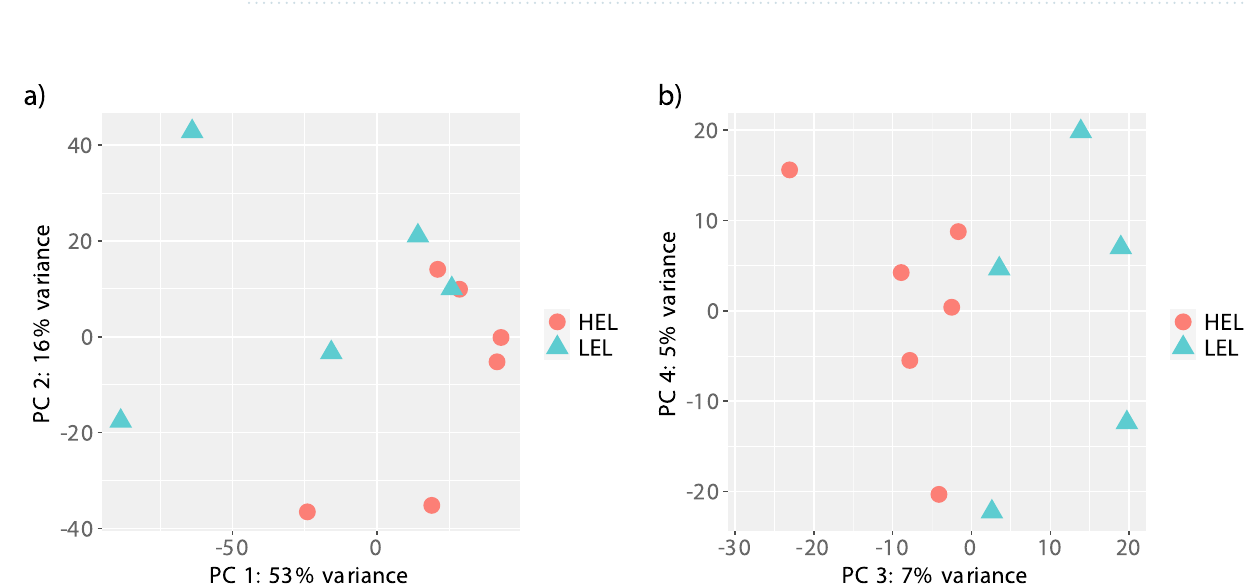
Table 1. Characteristics of ovarian transcriptome data of high and low egg laying Chara ducks.